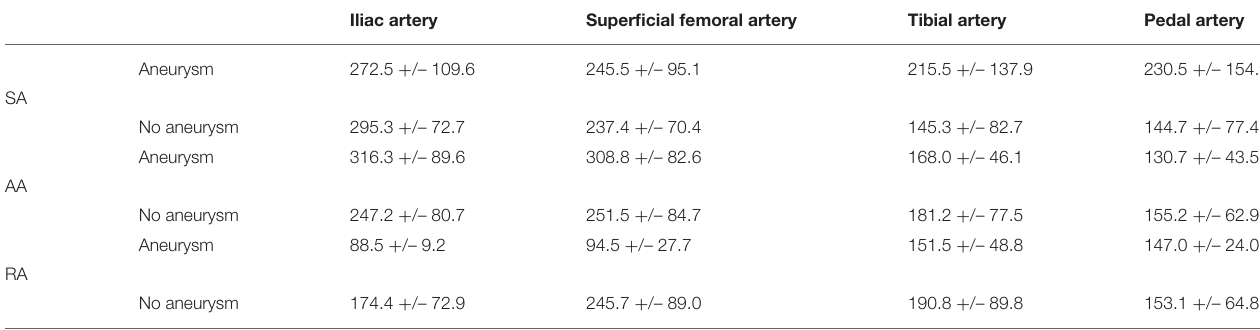
TABLE 4 | Mean attenuation [HU] + /– SD at the four distal vascular segments stratified by the presence or absence of aneurysm. Iliac artery Superficial femoral artery Tibial artery